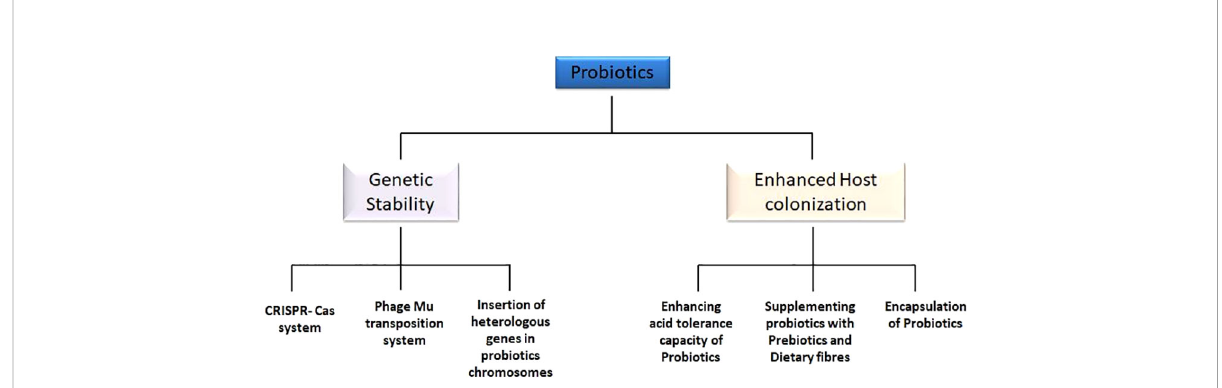
FIGURE 3 Challenges and current solutions to probiotic oral vaccines. Genetic stability and enhanced host colonizationare major innovative strategies to overcome the challenges faced by probiotic vaccines. Genetic stability includes the insertionof heterologousgenes in the bacterial chromosomes, adoptionof CRISPR-Cas system, as well as Phage-Mu transposition system. Enhanced host colonizationisachieved by enhancingacid tolerance capacity ofprobiotics, encapsulating probiotic cells, and supplementing probiotic cells with prebioticsanddietary fi